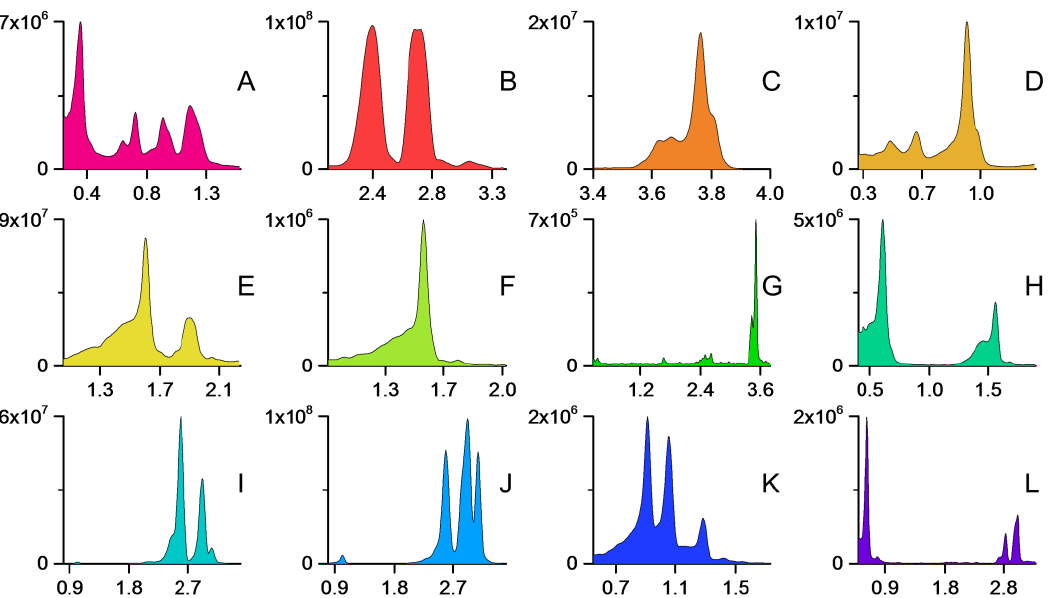
Figure 7. The LC–MS fingerprints of the studied species with the species-specific methods. ( A ) Acer platanoides , ( B ) Alnus glutinosa , ( C ) Alnus incana , ( D ) Fraxinus excelsior , ( E ) Populus tremula , ( F ) Prunus padus , ( G ) Quercus robur , ( H ) Salix phylicifolia , ( I ) Sorbus aucuparia , ( J ) Sorbus hybrida , ( K ) Syringa vulgaris , and ( L ) Tilia cordata . Tilia × europaea produced a similar fingerprint to that of Tilia cordata . The LC–MS fingerprints consisted of selected ion recording traces of 1–6 markers (Table